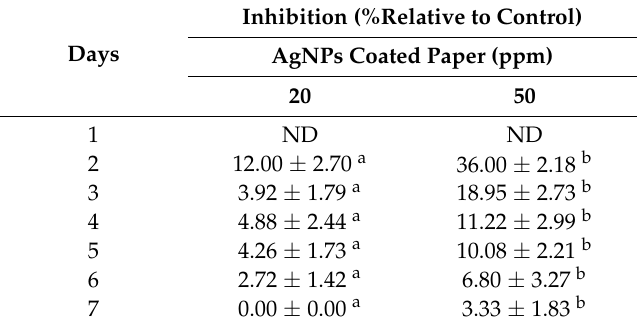
Colletotrichum Gloeosporioides fungi .